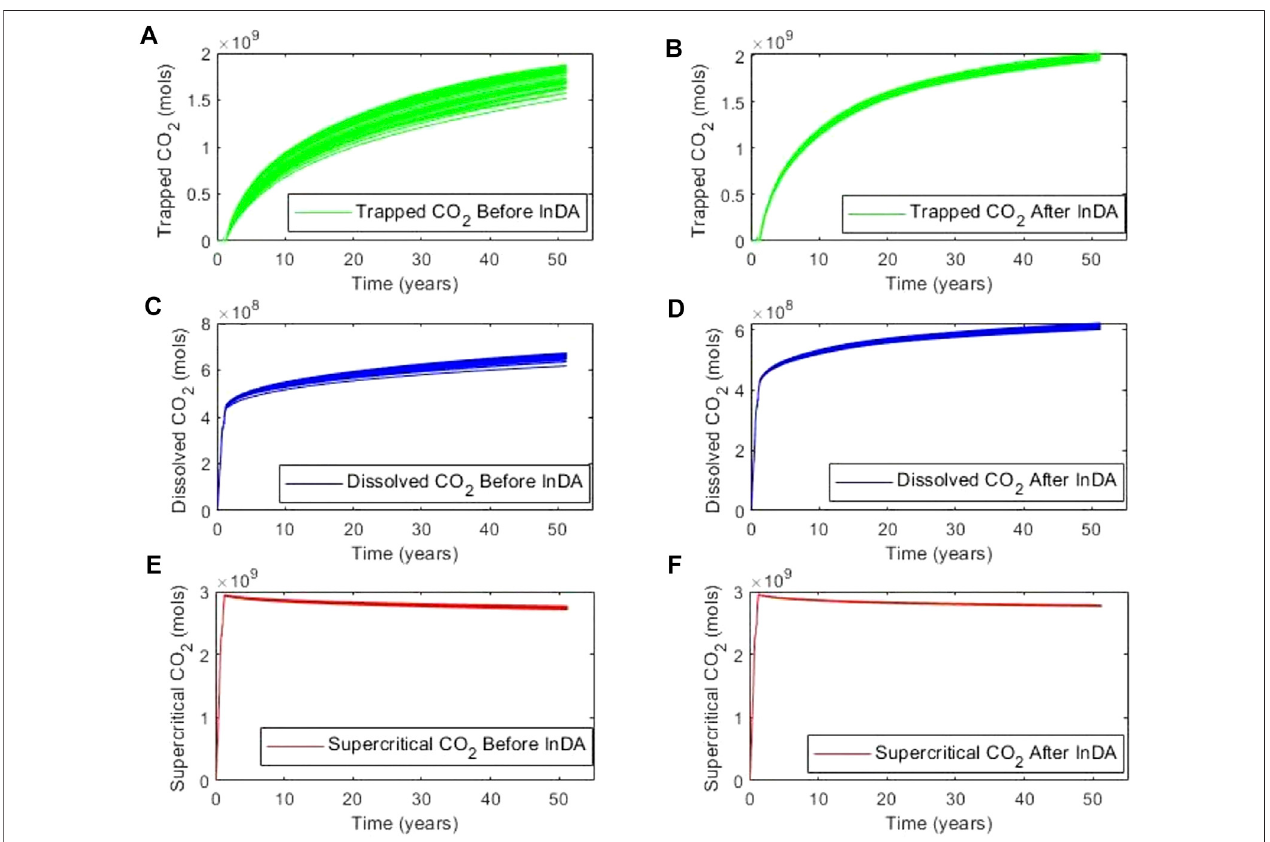
FIGURE 14 | CO 2 sequestration responses before and after permeability updates. Moles of residual trapped gas (A) before InDA and (B) after InDA. Moles of dissolved gas (C) before InDA and (D) after InDA. Moles of super critical CO2 (E) before InDA and (F) after InDA.